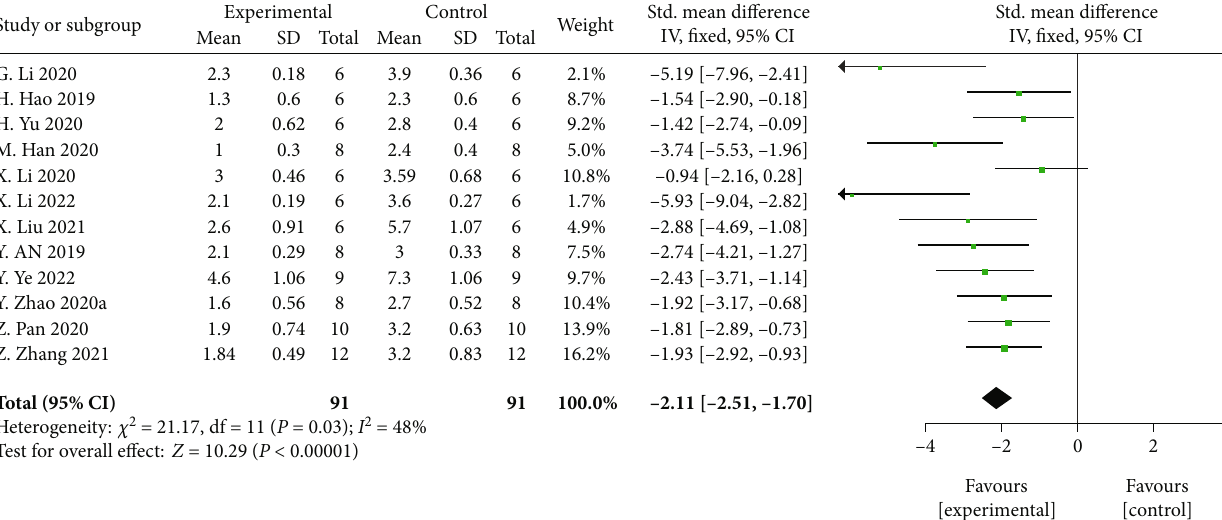
Experimental WeightControl Std. mean difference Study or subgroup Mean SD Total Mean SD Total